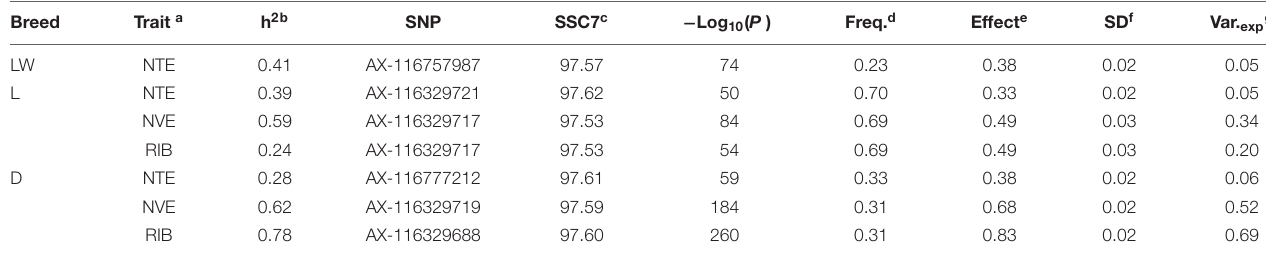
TABLE 2 | Heritability h 2 and parameters for the most significant SNP for each trait in each breed from the GWAS.